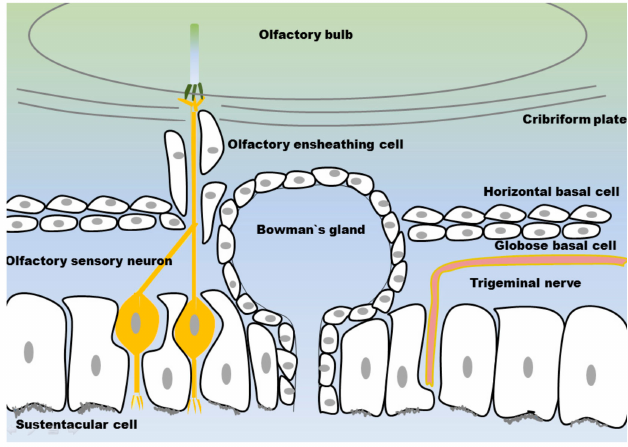
Figure 3. Structure of the olfactory mucosa: the olfactory sensory neurons (OSN) and the trigeminal nerve are embedded in a layer of supporting cells (sustentacular cells) and Bowman’s glands. Horizontal and globose basal stem cells are embedded in the lamina propria. The OSN axons are surrounded by olfactory ensheathing cells and form neuronal bundles. The neuronal bundles penetrate the cribriform plate and extend into the olfactory